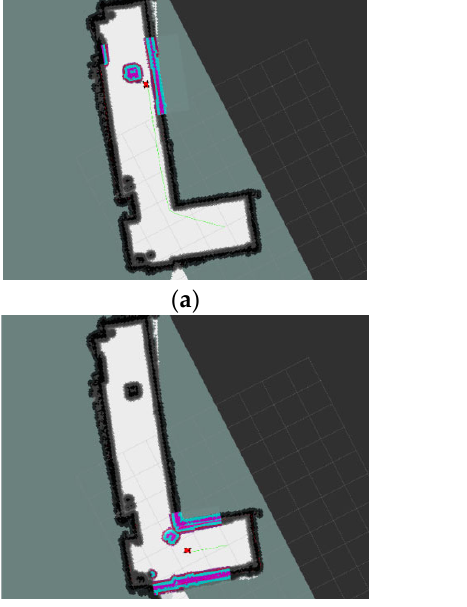
Figure 23. Navigation experiment in Rviz. ( a ) Start navigation; ( b ) Detect the obstacle; ( c ) Avoid the obstacle; ( d ) Reach the target point.